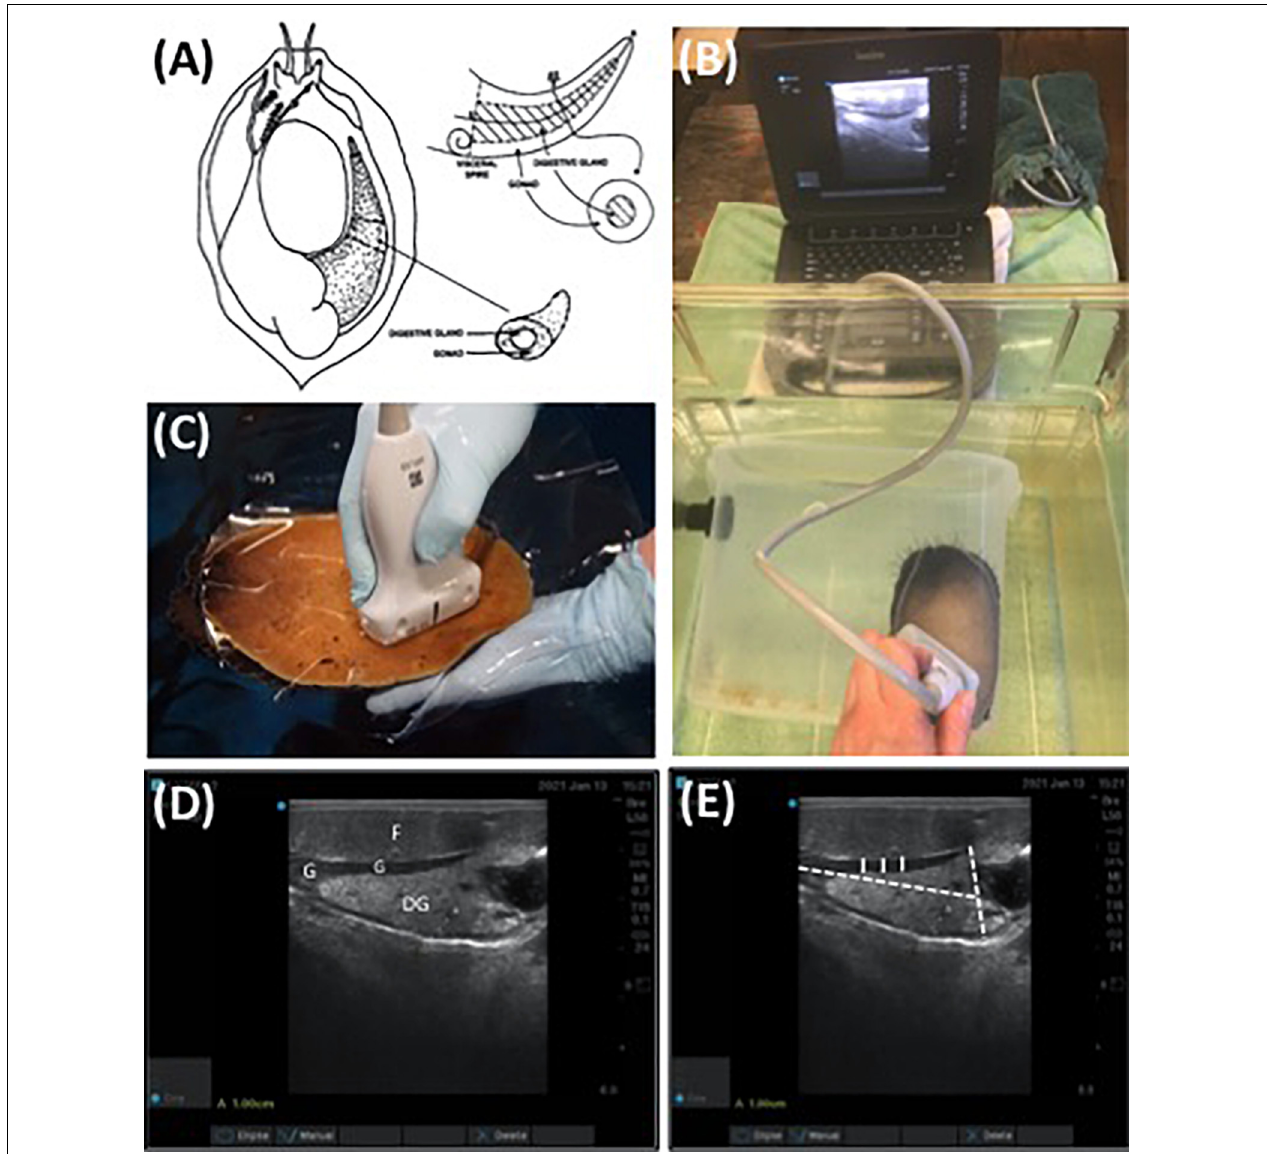
FIGURE 1 | (A) Diagram of abalone gonad and digestive gland (Rogers-Bennett et al., 2004), (B) non-invasive ultrasound assessment of red abalone ( Haliotis rufescens ) affixed to a submerged flow-through, polycarbonate aquaria, (C) ultrasound exam on red abalone immersed in seawater using transparency film, (D) ultrasound visualization of digestive gland (DG), foot (F), and gonadal tissue (G) of red abalone, and (E) replicate measurements of gonad thickness (solid white line) and maximum gonad cone height and length (dashed white line) were determined using non-invasive ultrasonography (D) . Scale bar (A) = 1 cm.